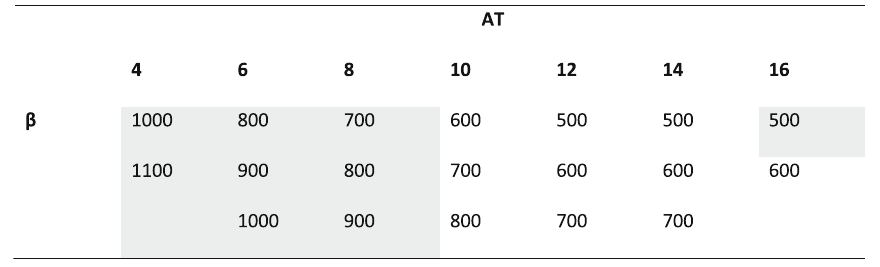
Table 1 Image quality from the pilot study. The β values for the image series that were ranked as the best in terms of overall image quality for each AT based on the pilot study of four patients. The image series highlighted in grey were further evaluated, in a blinded fashion, for image quality. Note that all 84 image series for each patient was visually